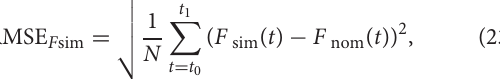
where k ω is the gain, and a ω a τ ω and the center frequency f ω a